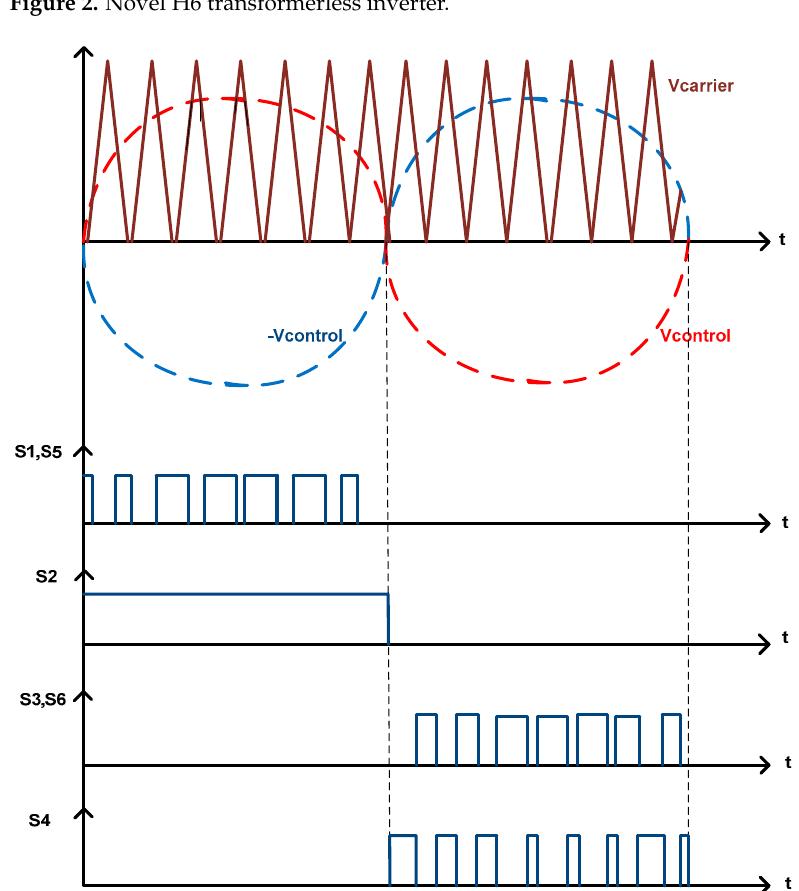
Figure 3. Modulation technique for novel H6 transformerless inverter .